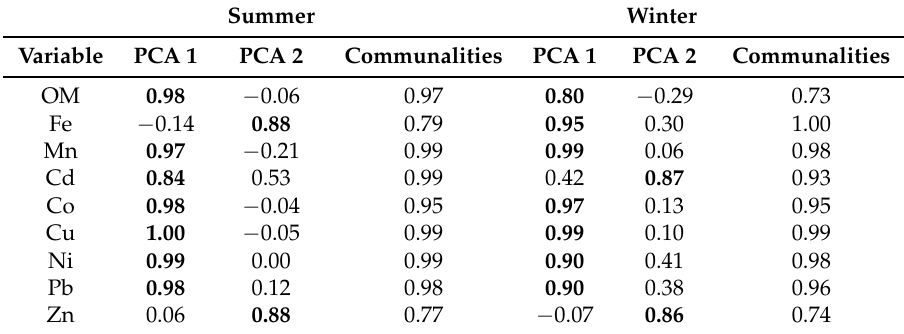
Table 4. Loadings matrices of the variables extracted while using varimax rotation. Bold-faced values are loadings >